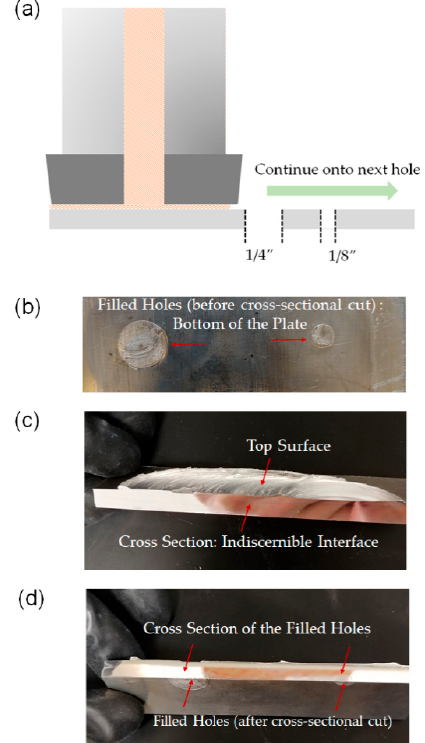
Figure 2. Depiction of hole filling by additive friction stir deposition, wherein the tool travels toward the hole (highlighted in red in image ( a )) and then dwells. Snapshots ( a ) right before hole filling; ( b ) start of hole filling; ( c ) partial covering of the hole during filling; ( d ) complete coverage of the hole during filling; ( e ) dwelling over the hole during filling; ( f ) tool retraction.